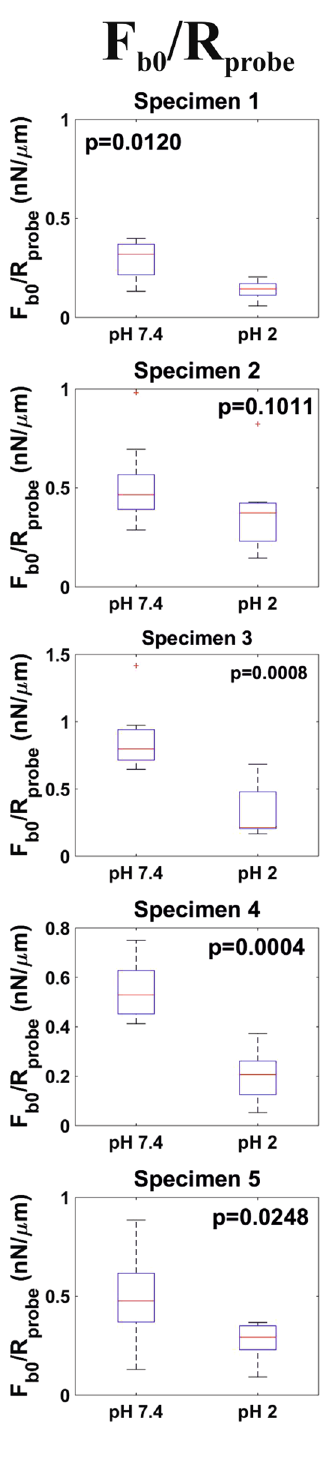
Figure 6. Distributions (n = 10) of Fb0/Rprobe values obtained at both pH 7.4 and pH 2 for all investigated